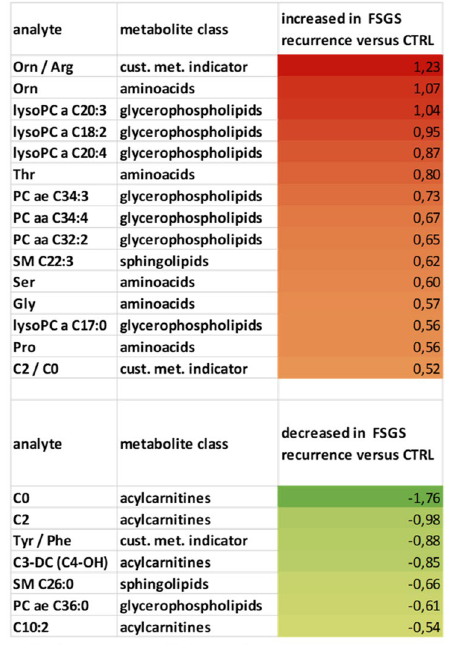
Table 2. Differences in serum metabolites of a transplanted patient with FSGS recurrence versus a transplanted control measured by mass spectrometry. Table shows metabolites that were increased > 0.5 and decreased > 0.5 in the FSGS patient competed to the control patient. All values are given as log2 (FSGS patient/stable transplanted control). Color shades represent values as heat map.